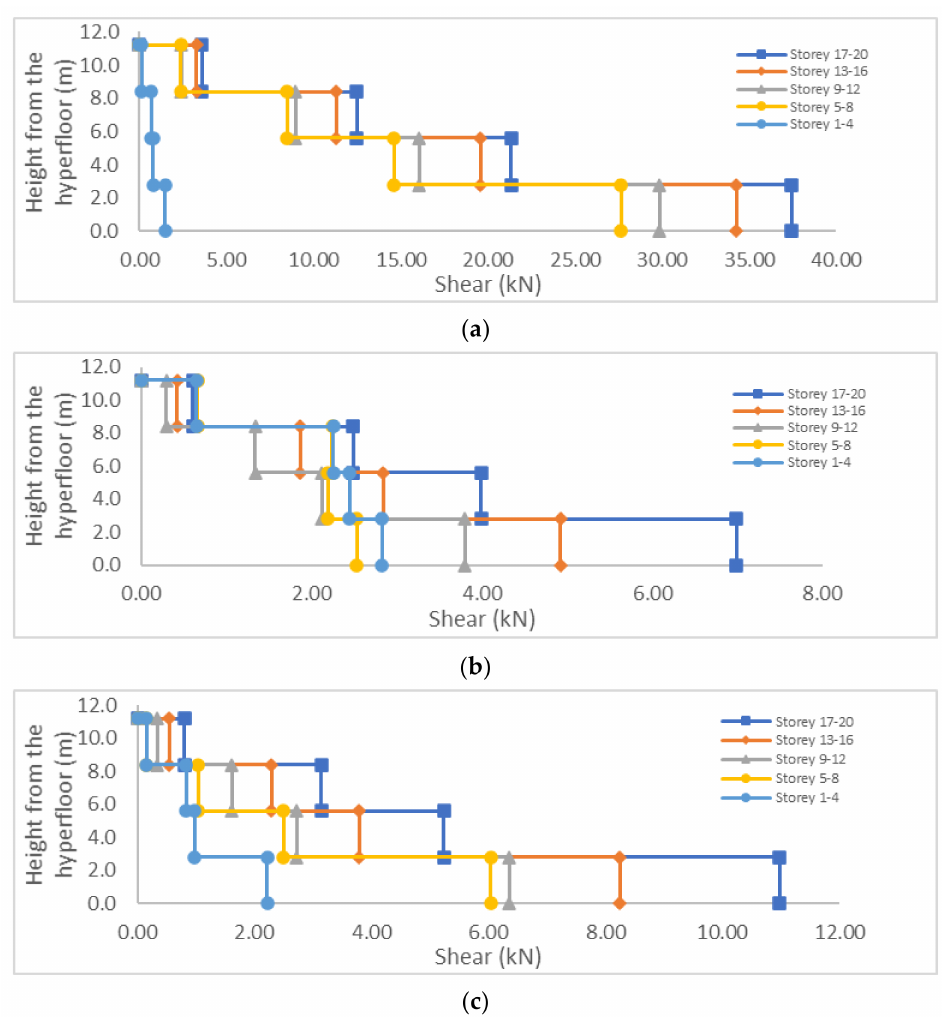
Figure 17. Shear experienced by the shearwall segments of the long modules under factored gravity- load combination 1.25 D + 1.5 L + 1.0 S. The end shearwall segments of 3.475 m length are shown in ( a ), the segment of 3.0 m length are shown in ( b ) and the segment of 3.5 m length are shown in ( c